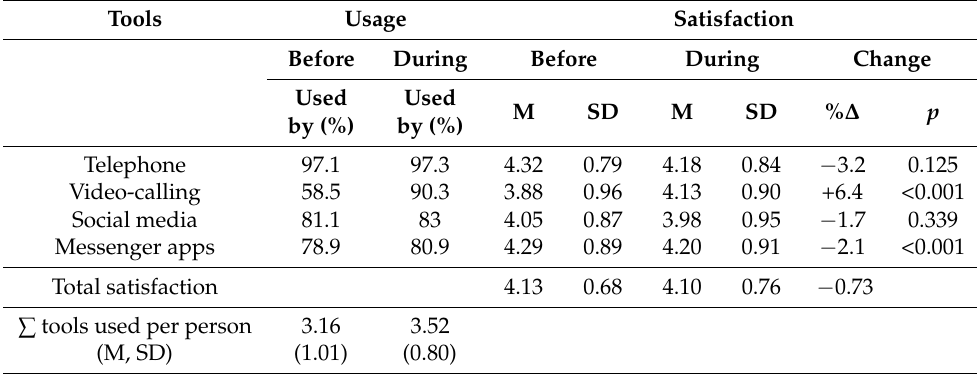
Table 3. Use of and satisfaction towards digital communication tools before and during home confinement among the general public (N =